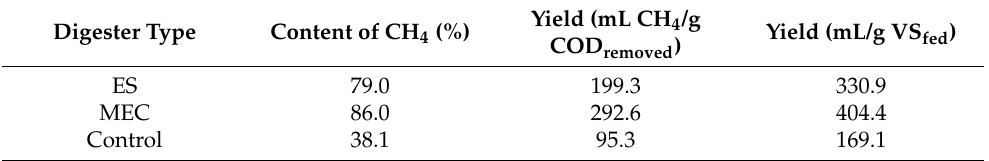
Table 1. Methane content and methane yield.